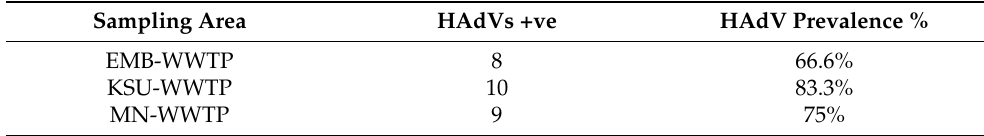
Table 1. HAdV prevalence in different water sample